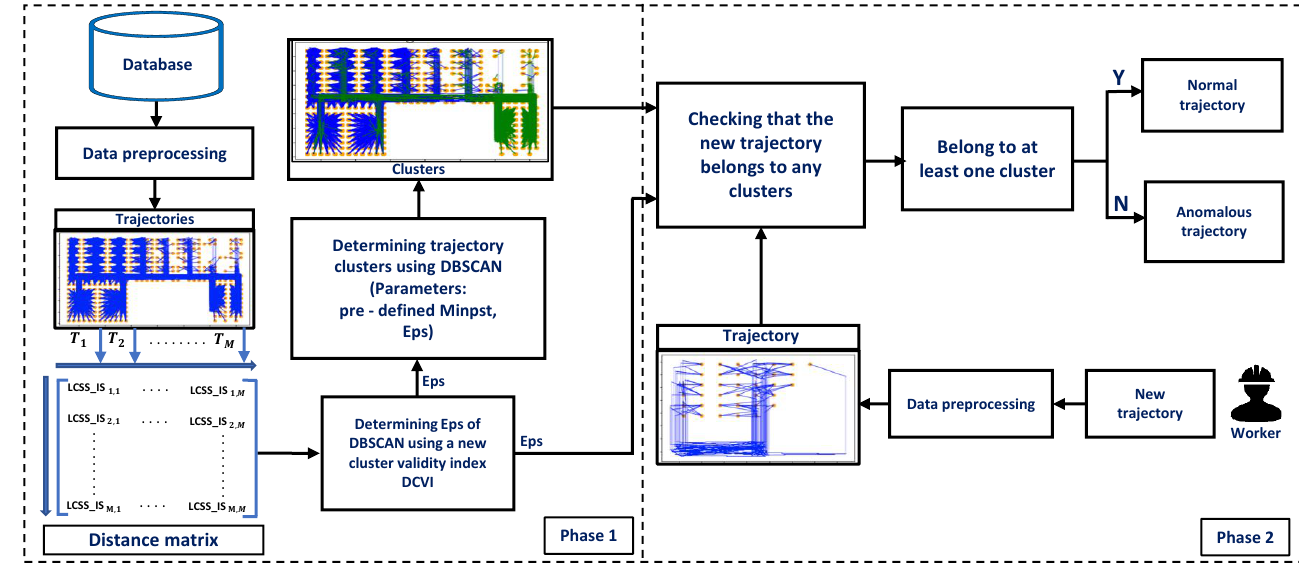
Figure 2. A two-phase framework for detecting human anomalous